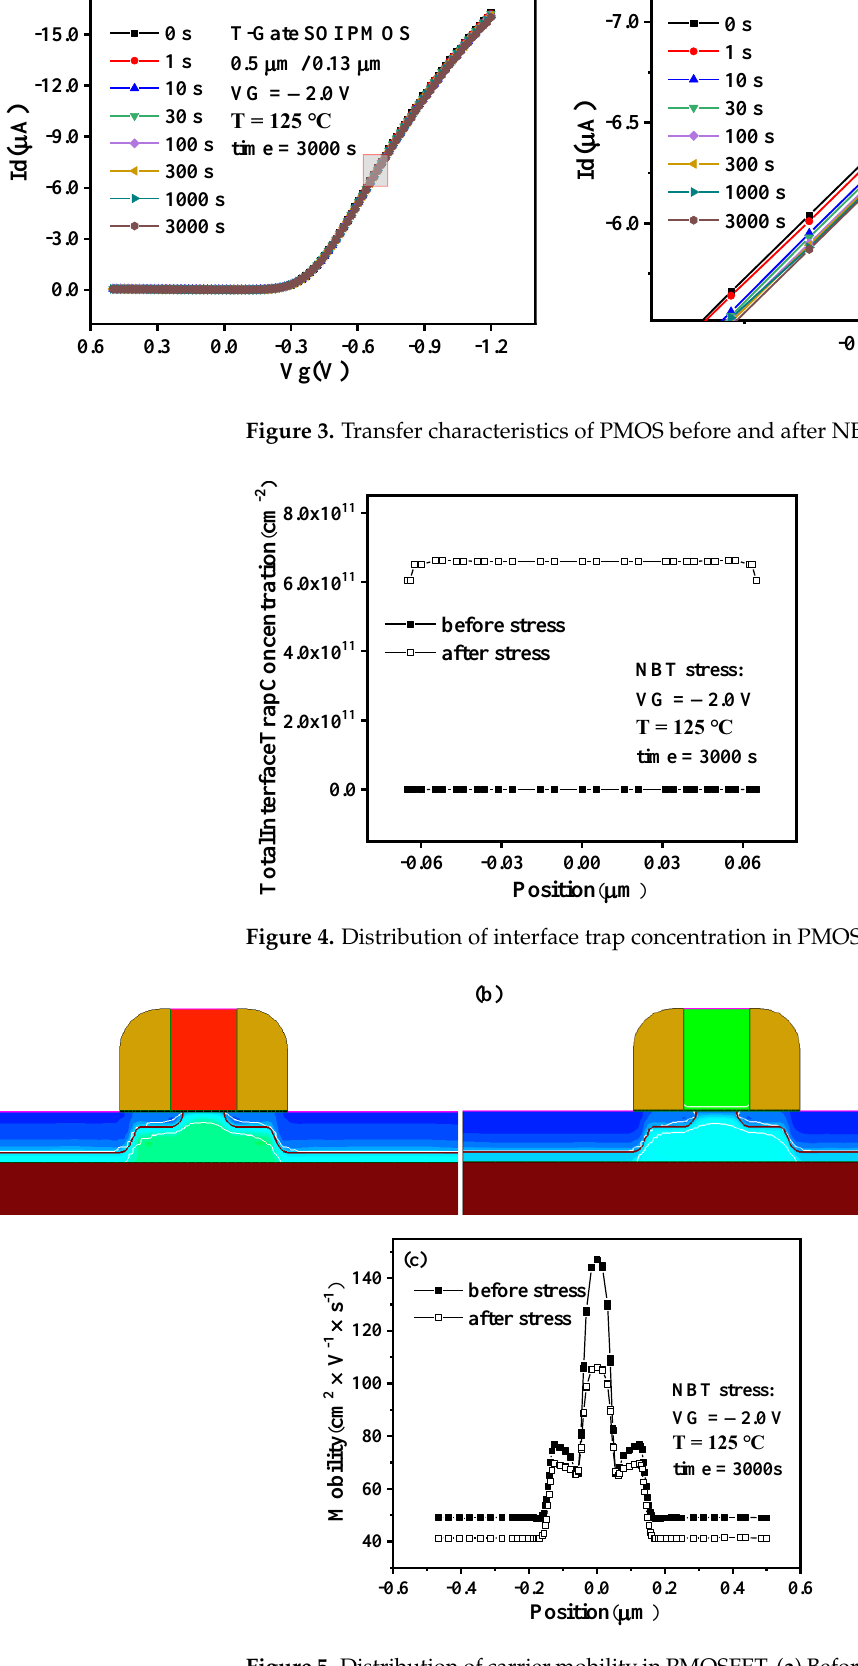
Figure 5. Distribution of carrier mobility in PMOSFET. ( a ) Before stress, ( b ) After stress, ( c ) Com- pared.